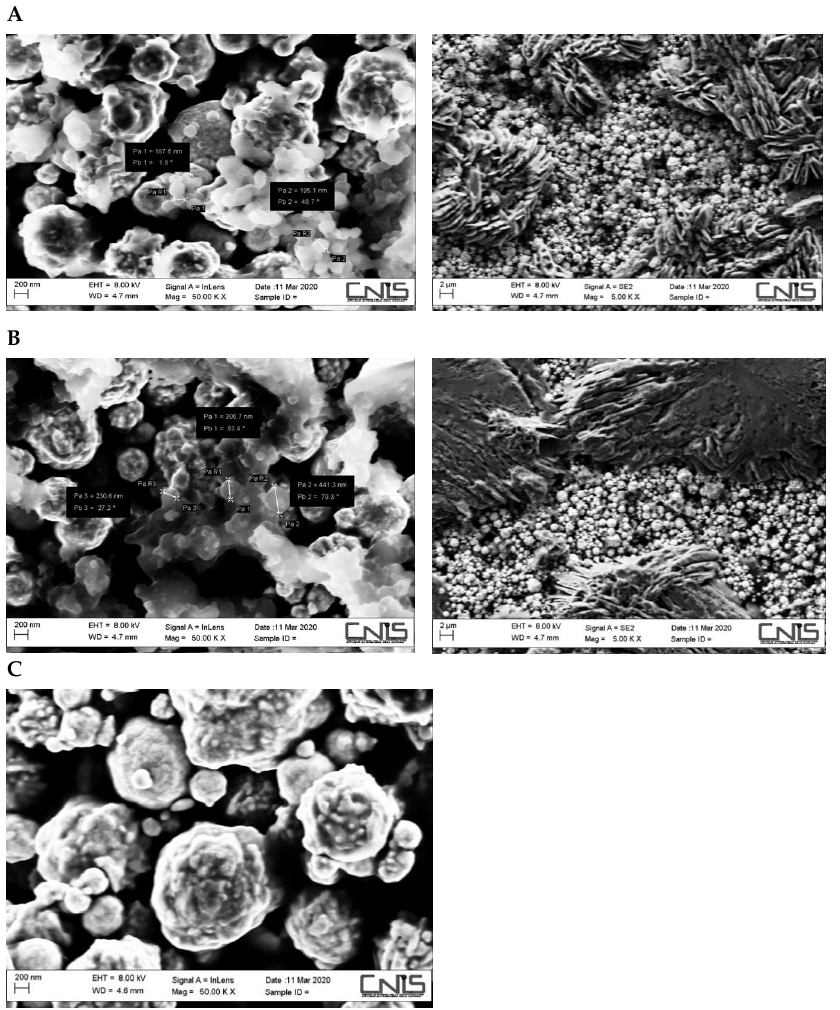
Figure 1. SEM images of OLNPs ( A ) and KLNPs ( B ) at two different magnifications and of Au bare electrode ( C ).